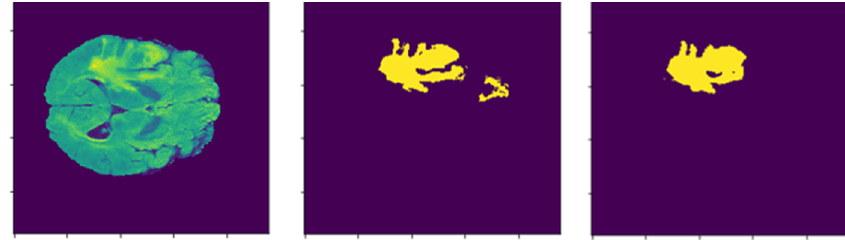
Figure 11. Lack of accurate